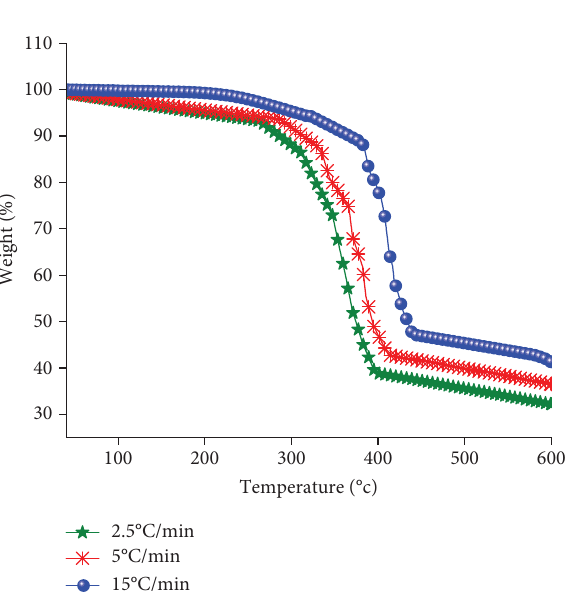
Figure 4: TGA curves of ACM-CB70 composites at diferent heating rates under nitrogen